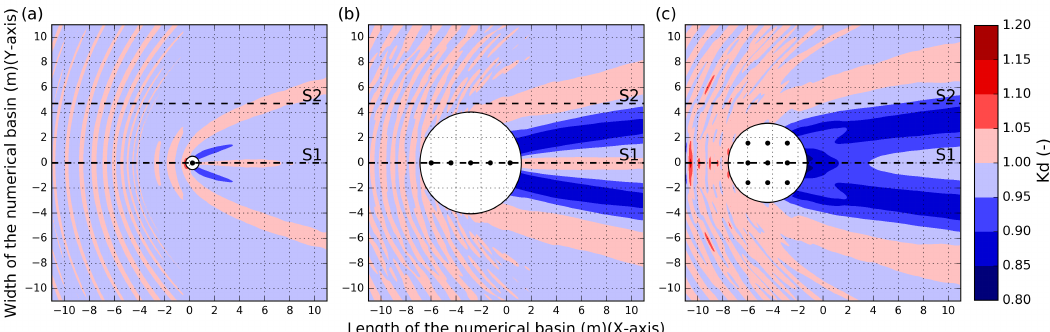
Figure 3. K d results for an irregular wave with T p = 1.26 s and H s = 0.104 m obtained using the MILDwave-NEMOH coupled model: ( a ) Test Case 2; ( b ) Test Case 4 and ( c ) Test Case 6 of Table 1. Contour levels are set at an interval of 0.05 of K d value (-). The coupling region is masked out using a white solid circle which includes the WECs (indicated by using black solid circles). Incident waves are generated from the left to the right. S1 and S2 indicate the location of